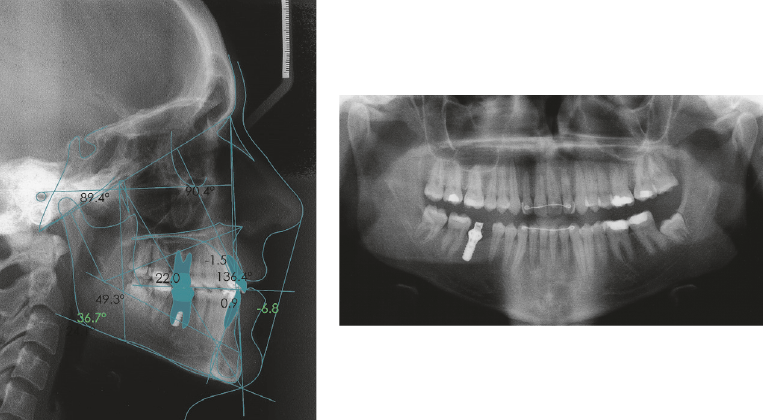
Figure 5: Lateral and panoramic final